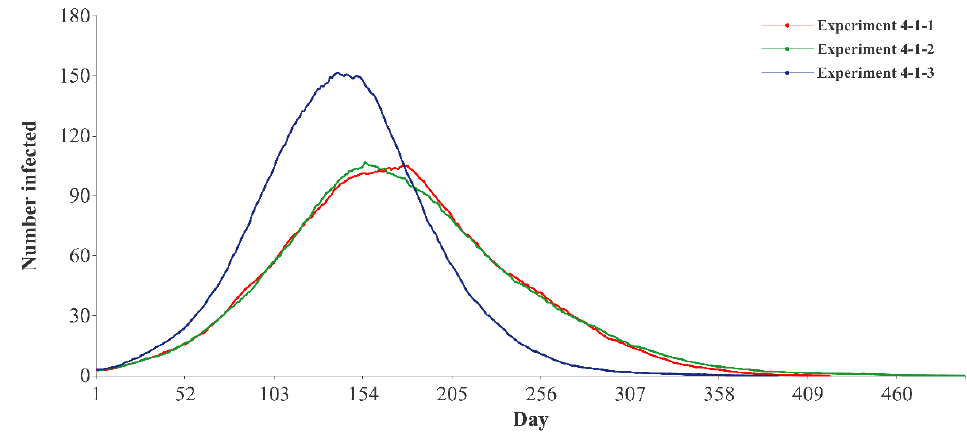
Figure 6. Infection curves of different kinds of going-out needs with strict policy